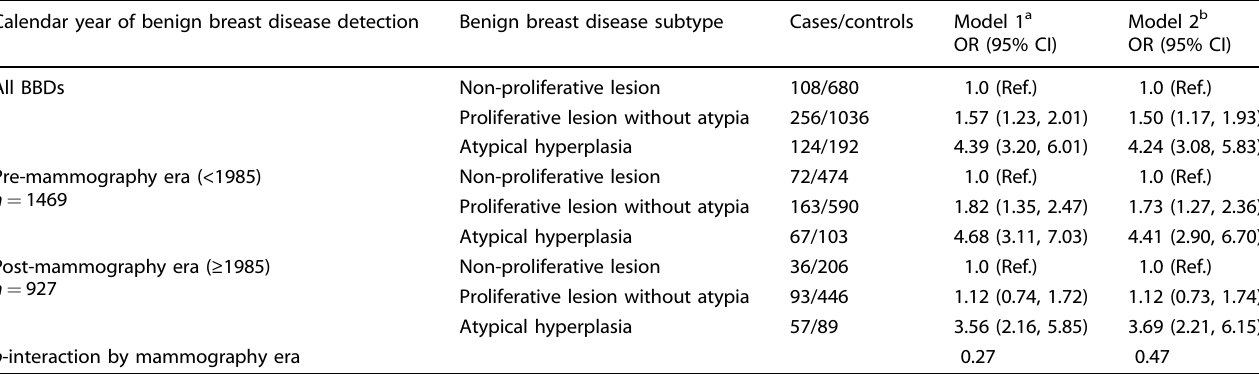
Table 2. OR and 95% CIs for the associations between benign breast disease subtypes and breast cancer risk, strati fi ed by pre- (before 1985) vs. post- mammography era (1985 and after) of BBD